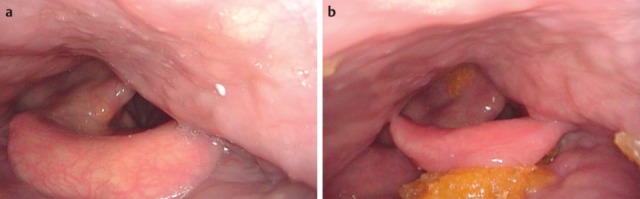
53-year-old patient with stiffening of the cervical spine and revision surgery, persisting dysphagia: a – the left lateral pharyngeal wall protrudes over the larynx with contact to the epiglottis; b – small bolus in the vallecula (physiological), transportation disorder of the bolus (carrots) in the right hypopharynx.